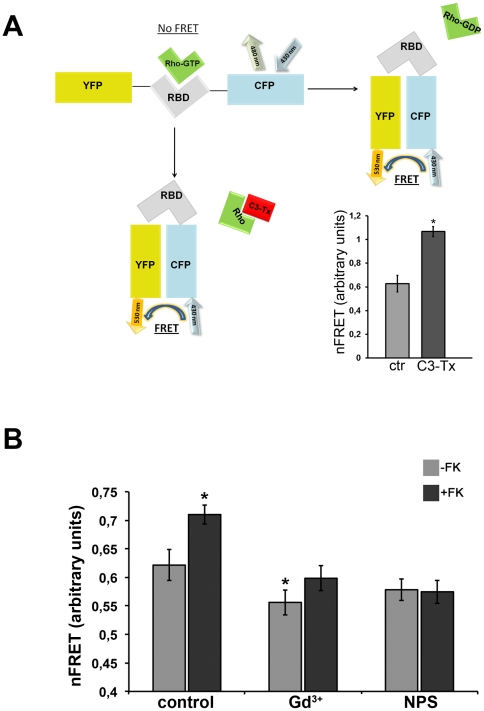
RhoA activity in cells exposed to CaR agonists.
A. Scheme of the Raichu-RBD probe mechanism. Raichu-RBD contains YFP and CFP separated by rhotekin-RBD (RBD). Active RhoGTP binds RBD, separating the donor (CFP) from the acceptor (YFP) thus reducing FRET. As internal control MCD4 cells were incubated for 3 hours with C3 toxin (1 µg/ml), which inactivates Rho proteins, and FRET signals was recorded. As shown in the figure, C3 toxin (1 µg/ml for 3 hours) (n = 124) leaded to a ‘closed’ conformation increasing FRET compared to control cells (n = 71). B. Rho activity during CaR activation. RhoA activity was evaluated in MCD4 cells exposed to CaR agonists. MCD4 cells were preincubated with 5 mM Ca2+, 300 µM Gd3+ or 10 µM NPS-R 568 for 30 min and then stimulated with 10−4 M FK or analyzed at rest. The amount of active RhoA was evaluated by FRET using a probe consisting of a Rho-binding domain (RBD) of Rhotekin sandwiched by YFP and CFP (see Methods). In this system, any increase in RhoA activity results in a decrease in FRET efficiency. In non-treated cells, FK stimulation (n = 59) caused a significant decrease in the amount of active RhoA compared to control conditions (n = 51). In cells pretreated with 300 µM Gd3+, RhoA activity was significantly increased (decreased FRET signal, n = 50) compared to control untreated cells. The decrease in RhoA activity in response to FK was prevented in cells preincubated either with Gd3+ (n = 66) or NPS-R 568 (n = 60). Values are expressed as mean ± SEM Data were compared by one-way Anova and Tukey's multiple comparison test (*P<0.05 relative to control).